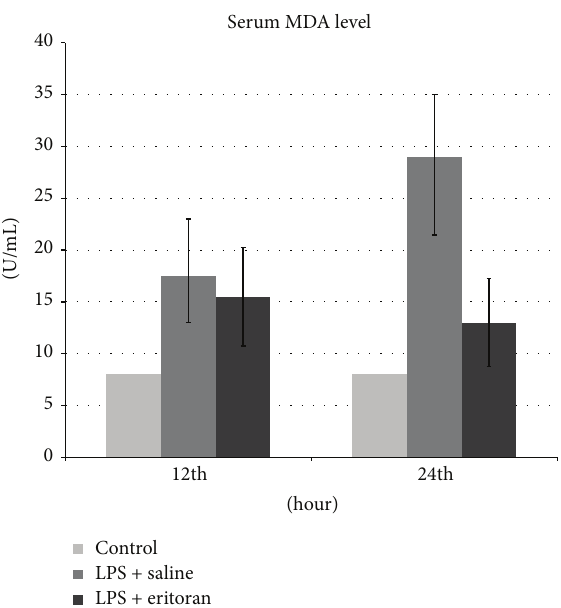
Figure 3: The malondialdehyde (MDA) levels in serum after 12 h and 24 h in control group with no intervention, rats with sepsis but without eritoran, and rats with sepsis treated with eritoran. Vertical lines show standard deviation. LPS: lipopolysaccharide.